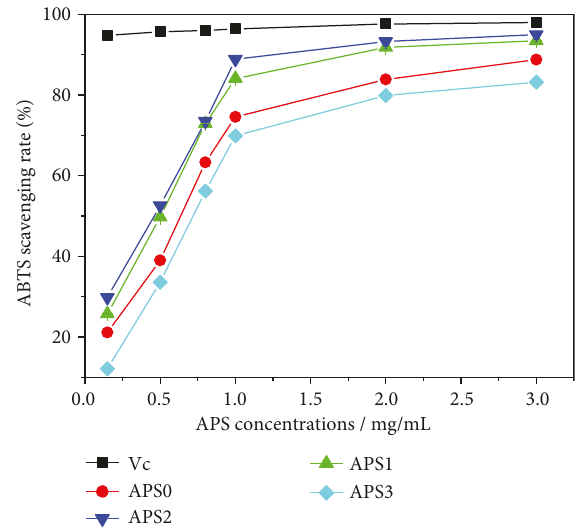
Figure 5: ABTS radical scavenging capacity of APS with di ff erent molecular weights.